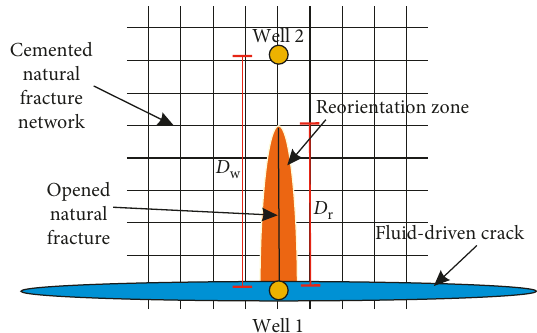
Figure 12: Schematic diagram of water channelling.